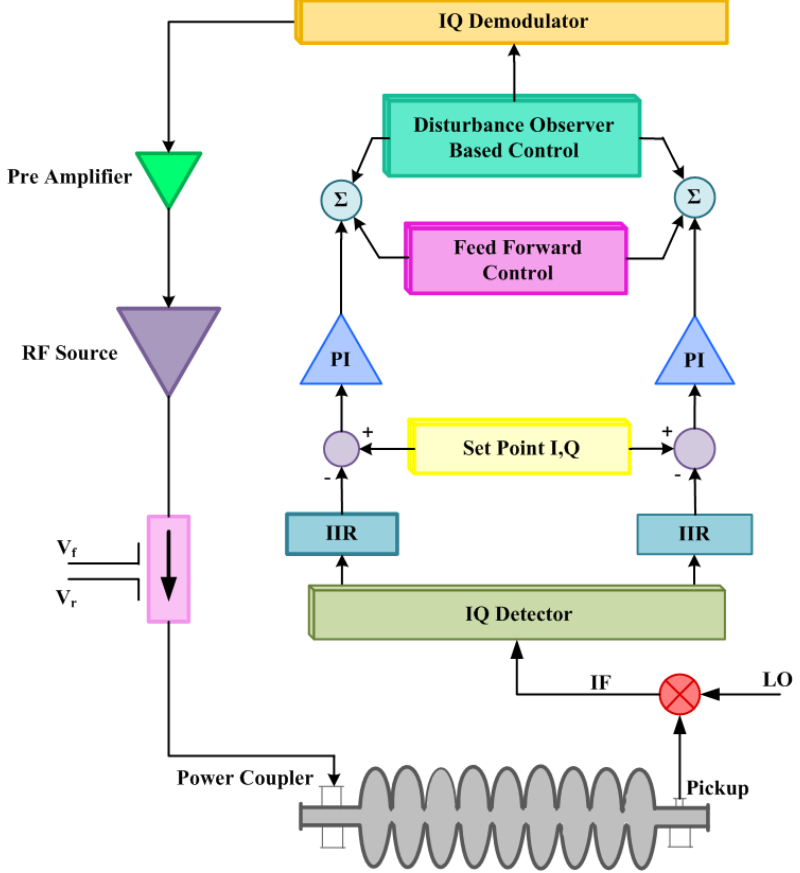
Figure 1. A generalized cavity field control